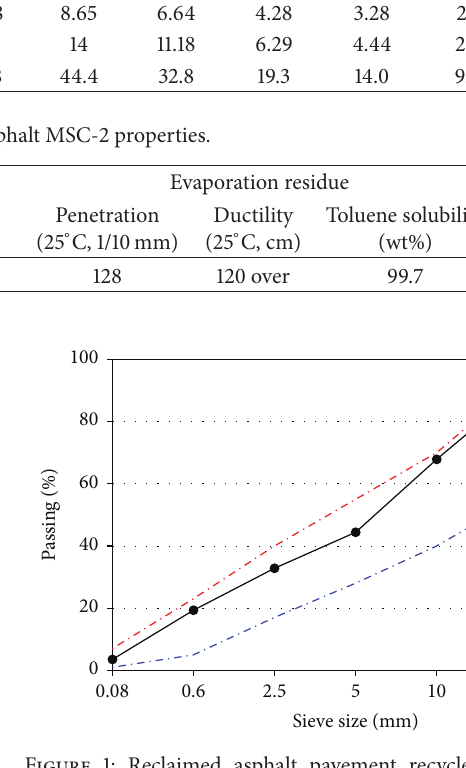
Figure 1: Reclaimed asphalt pavement recycled aggregate size distribution